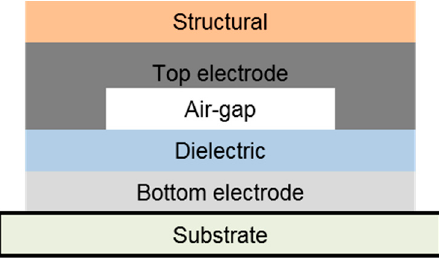
Figure 2. Schematic of the air-gap touch sensor.